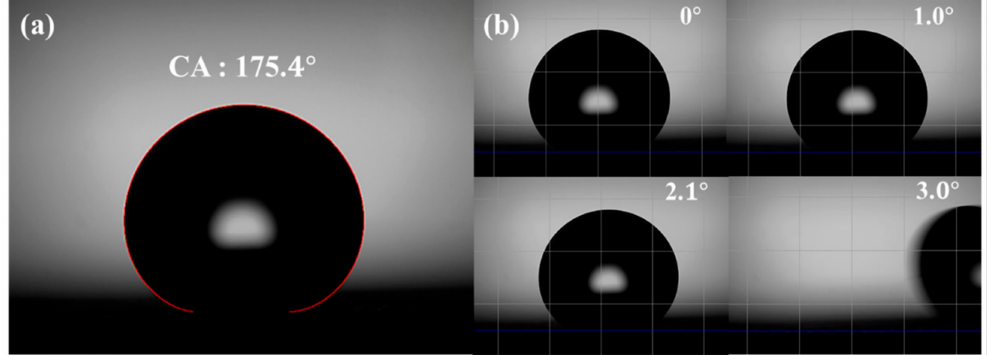
Figure 3. Wettability results of the fabricated PP/SNPs coated films for ( a ) CA and ( b )